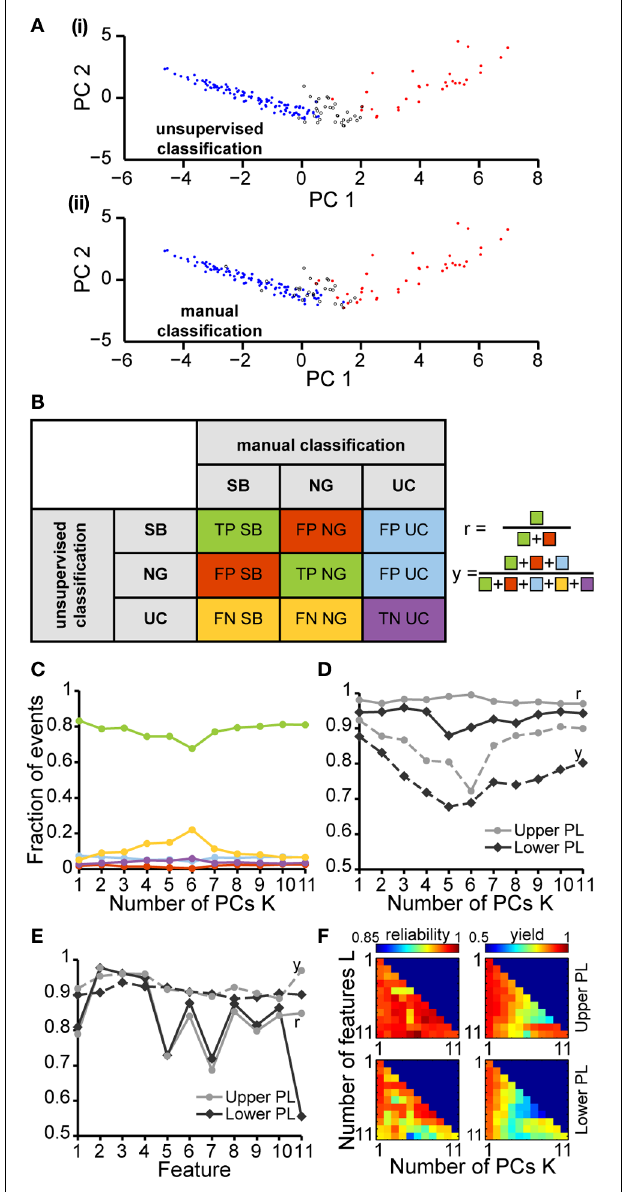
FIGURE 4 | Unsupervised classification of oscillatory events in the PL of neonatal rats. (A) Validation of the unsupervised classification (i) by comparison with the manual classification (ii) of oscillatory events from the same recording. Each dot corresponds to the projection of the feature vector of one event into the principal component space spanned by the first two principal components. The colors code the results of the classification (SB, blue; NG, red). Events that cannot be assigned to one class of oscillations are displayed as white dots (unclassified events, UC). (B) Left, table defining the results of unsupervised classification vs. manual classification. Oscillatory events classified as either SB or NG by both methods were defined as true positives (TP SB , TP NG , green), whereas events wrongly assigned by the unsupervised method when compared to the manual classification were defined as false positive (FP SB , FP NG , red). Events that were automatically classified as SB or NG, but were left unassigned by the manual classification were defined as false positive unclassified (FP UC , blue). Automatically unclassified events were defined